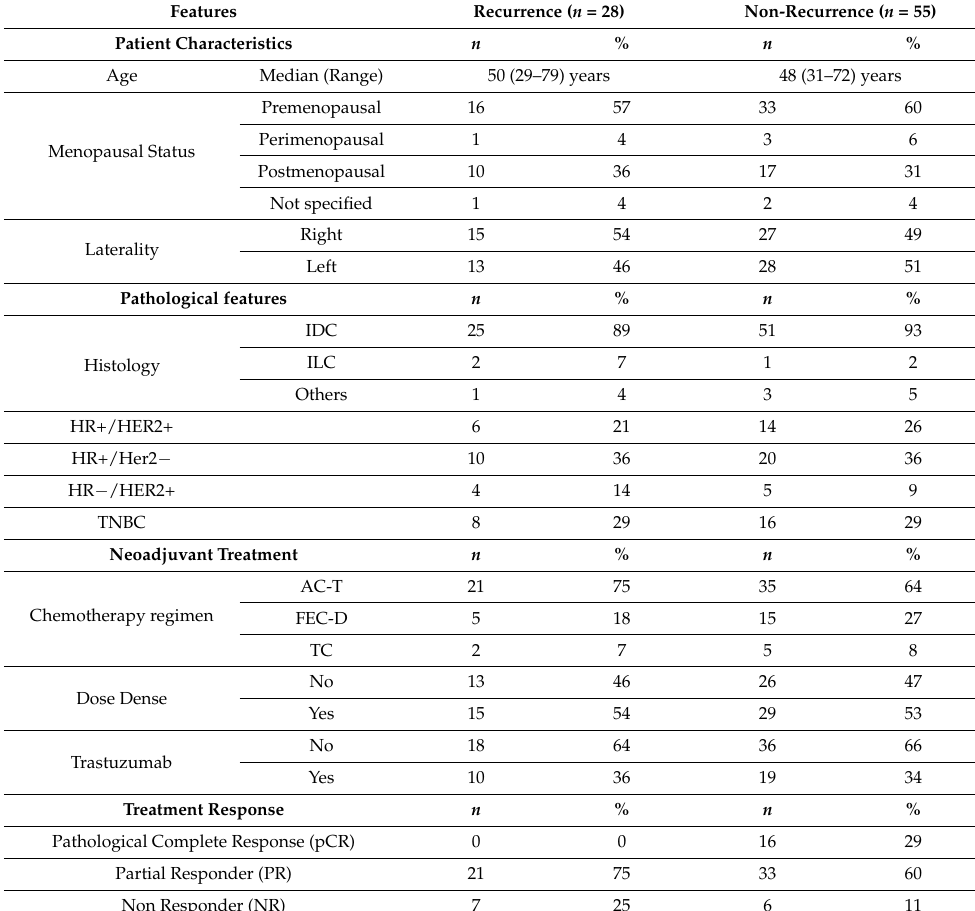
Table 1. Patient, disease, and treatment-related characteristics for all patients ( n = 83).